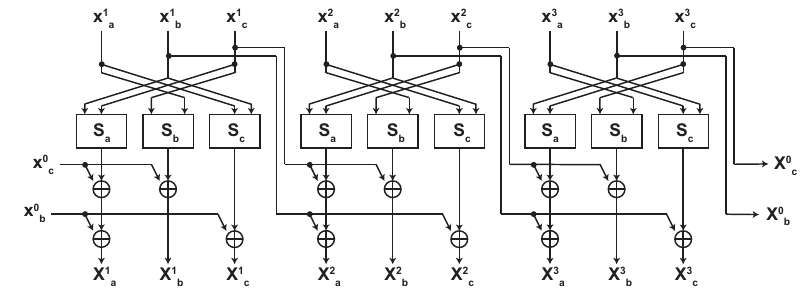
Figure 1: Changing of the Guards